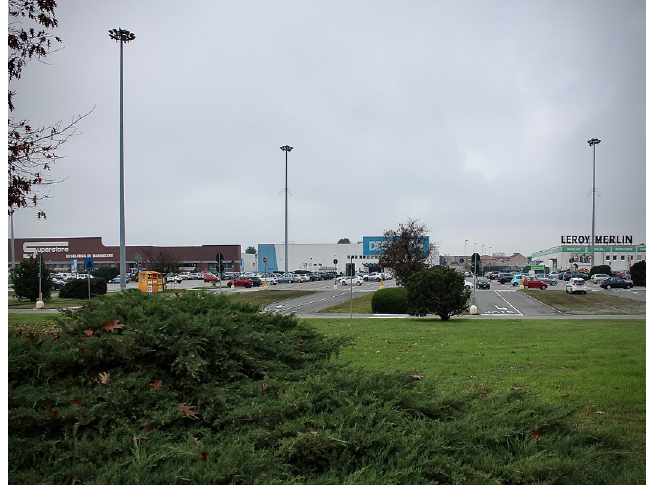
Fig. 17 Non-places: the big suburban shopping centers of